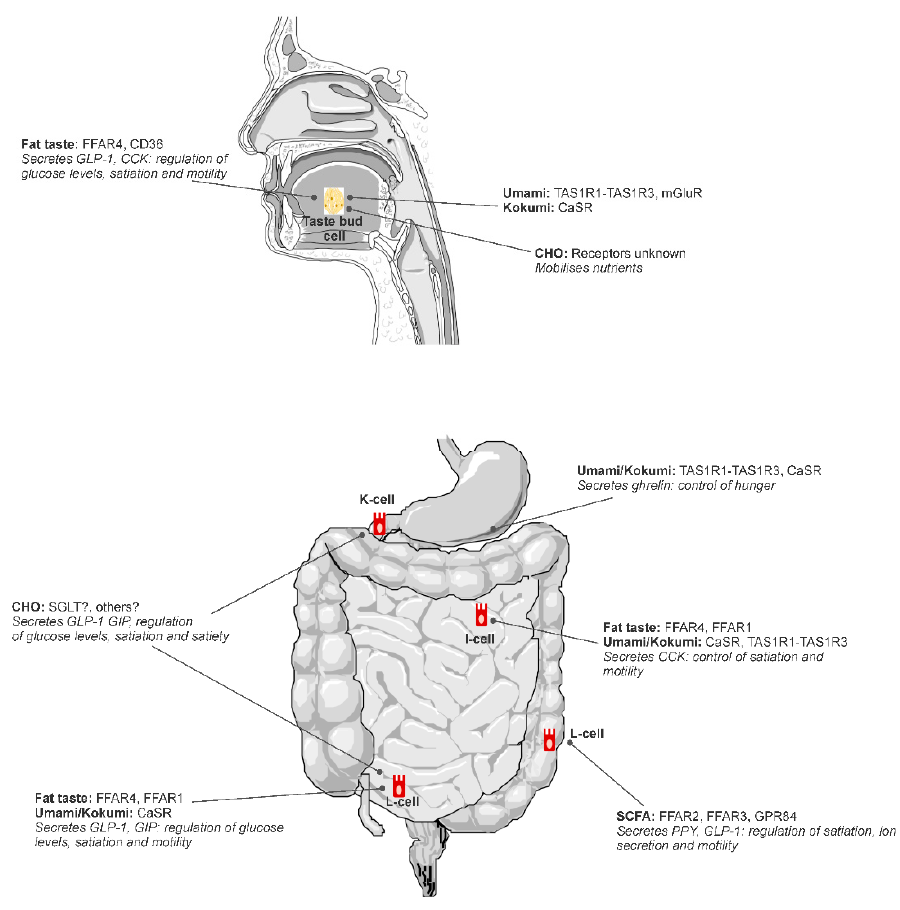
Figure 1. A diagram of putative and potential alimentary taste receptors throughout the alimentary canal. Reproduced from [18].